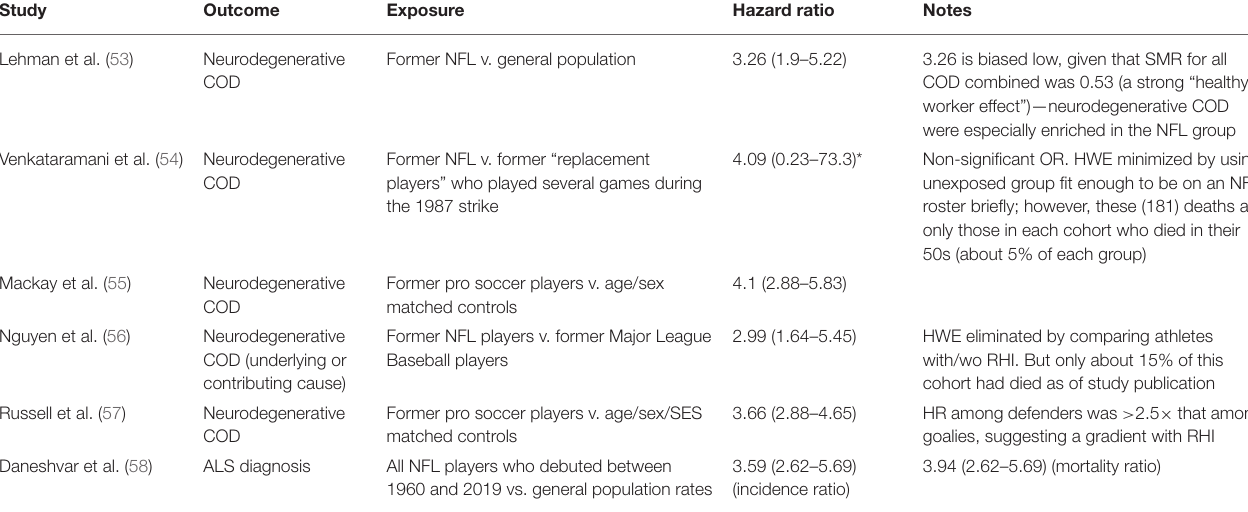
TABLE 2 | Other important strength of association results.